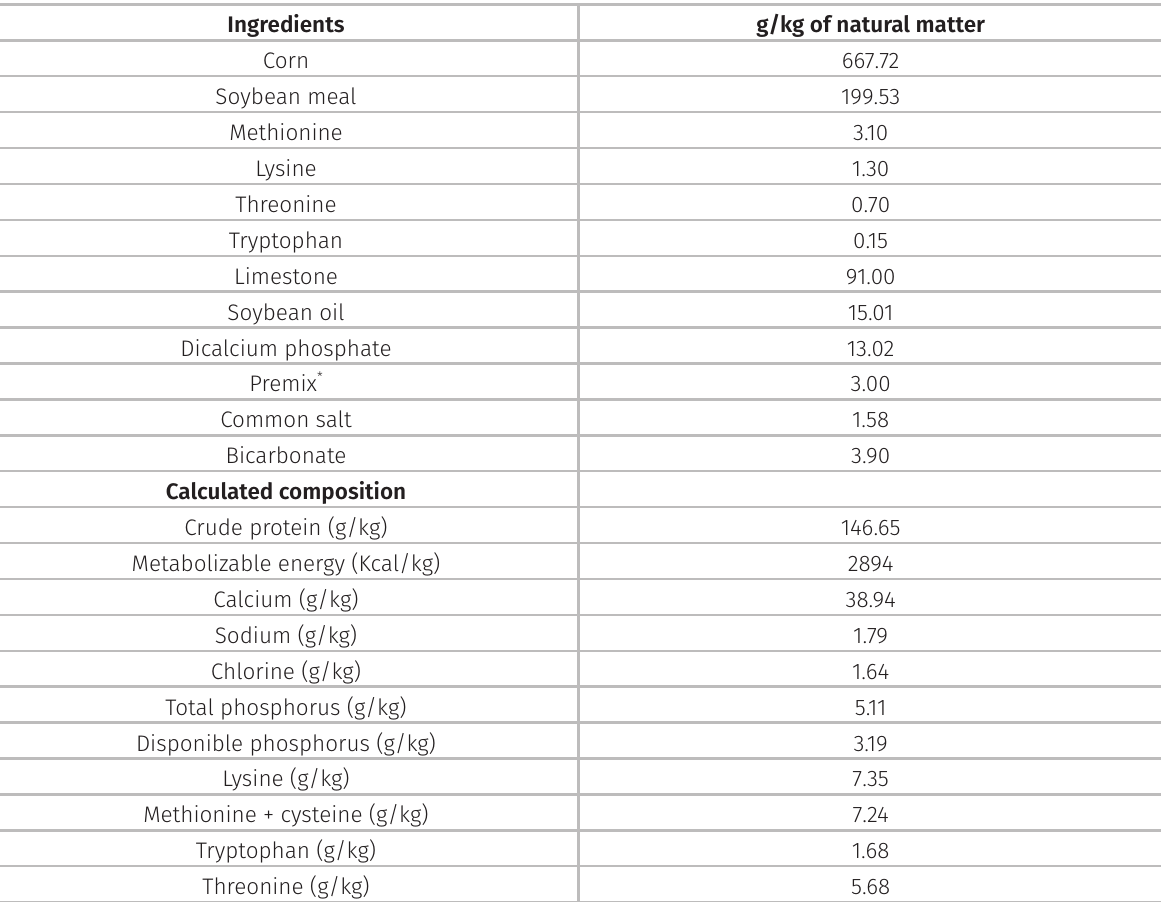
Table I. Composition of the experimental diets: ingredients, and calculated composition.